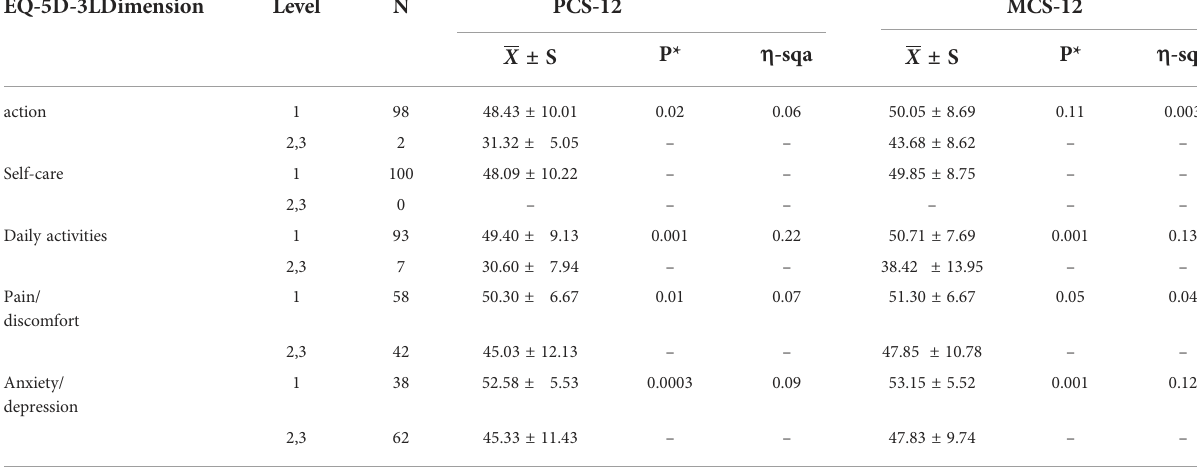
TABLE 4 Comparison of SF-12 scores in different dimensions of EQ-5D-3L. EQ-5D-3LDimension